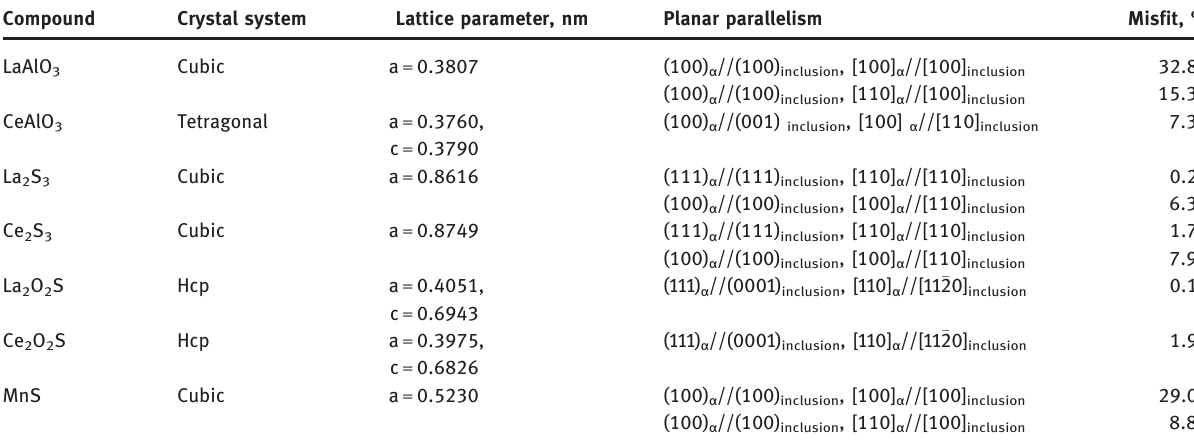
Table 2: Misfit values between particle constituent phases and ferrite.